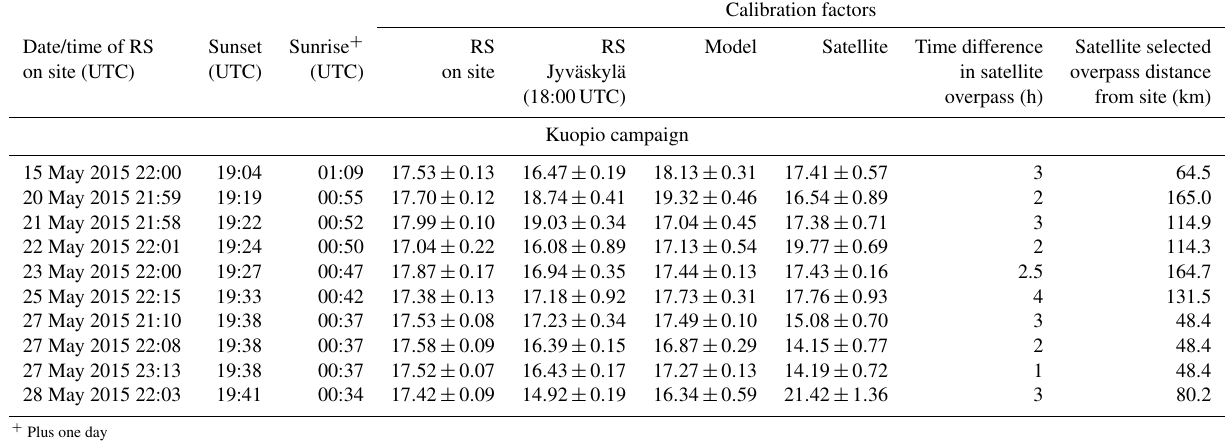
Table 2. Lidar calibration factors and errors derived from RS, model and satellite data during Kuopio campaign. Calibration factors from the nearest radio sounding site located in Jyväskylä airport ( ∼ 100km away) are also shown. For satellite overpasses the distance between the lidar site and the selected footprint along with the time difference from the RS launch time is available. Note: the same satellite overpass has been used on 27 May 2015, where multiple RSs were launched in a 1h interval.